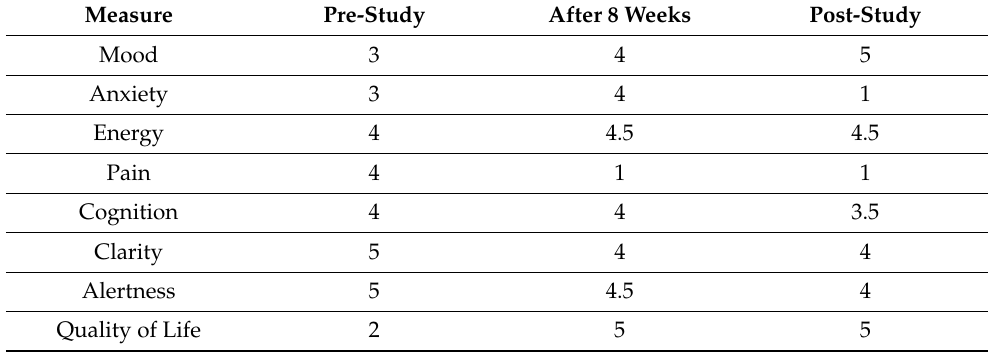
Table 3. Case Three: Likert Scale